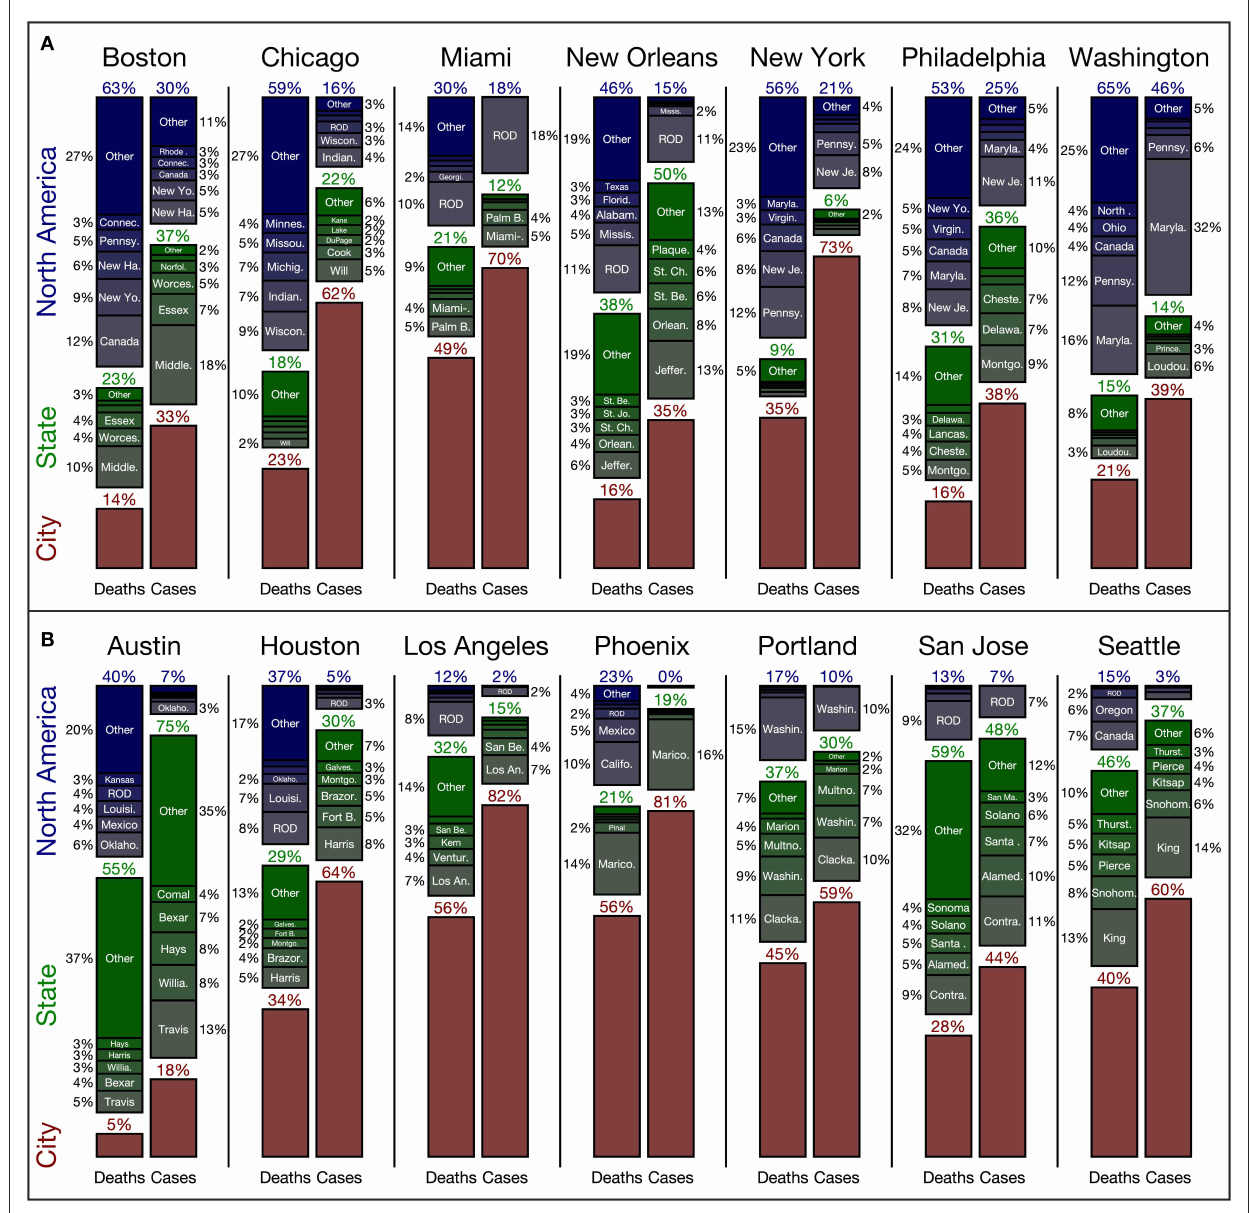
FIGURE3 Regional contributions to air pollution-related health impacts in (A) the eastern and (B) the western US. We consider separate breakdowns for PM 2.5 - and O 3 -related premature deaths (left) and NO 2 -related new asthma cases (right) for each city. In red are municipal contributions; in green are contributions from the state the city is in, broken down by county; and in blue are contributions from the rest of North America broken down by state. We consider the top five county and state contributions; all other contributions for each category are labeled as “other.” Contributions < 2% are not labeled. The term ROD refers to “rest-of-domain” and includes all emissions outside of the US, Mexico, and Canada, including shipping emissions within the nested US GEOS-Chem